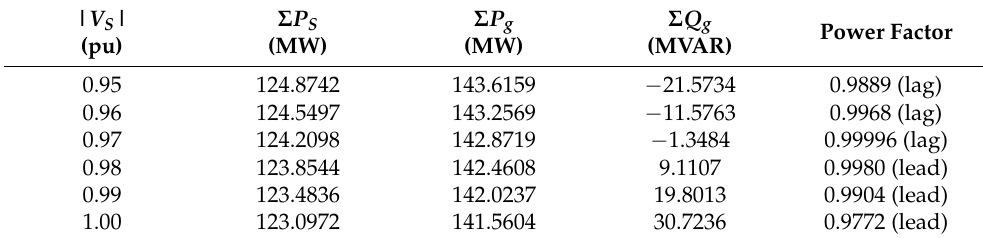
Table 14. Stator power, WPP output and power factor ( V w = 10 m/s).